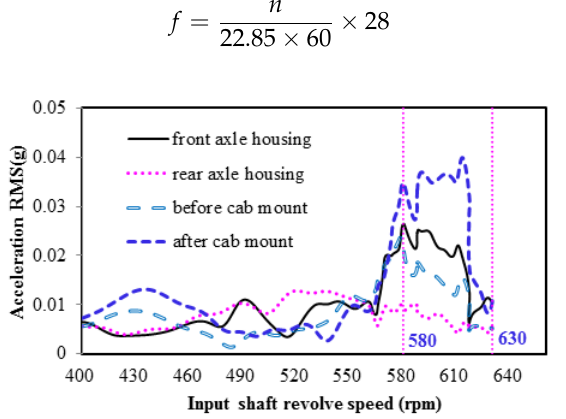
Figure 6. Comparison of 1.22 order vibration in the y- direction.